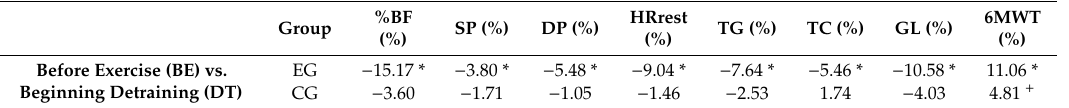
Table 2. Percentage change in lipidic, glycemic and hemodynamic profiles and cardiorespiratory fitness after the nine-month multicomponent exercise program. %BF HRrest Group SP (%) DP (%) (%)